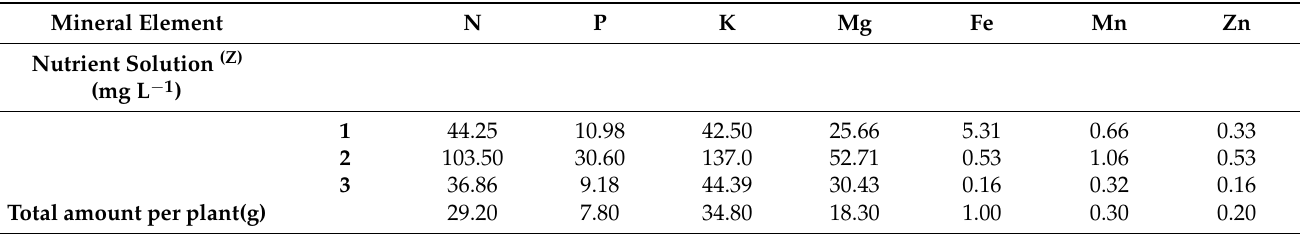
Table 10. Mineral concentration (mg L − 1 ) of the three different nutrient solutions applied according to the different phases of growing cycle and total amount (g) of supplied elements per plant z .